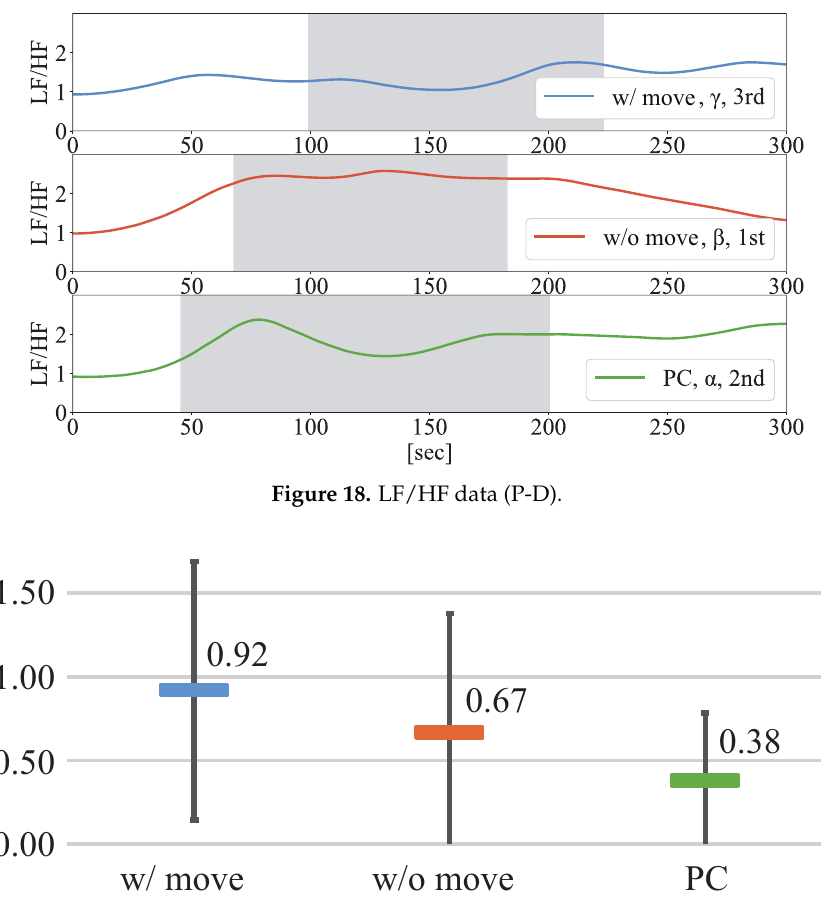
Figure 19. Average of the difference between the maximum value and the start point data of LF/HF.